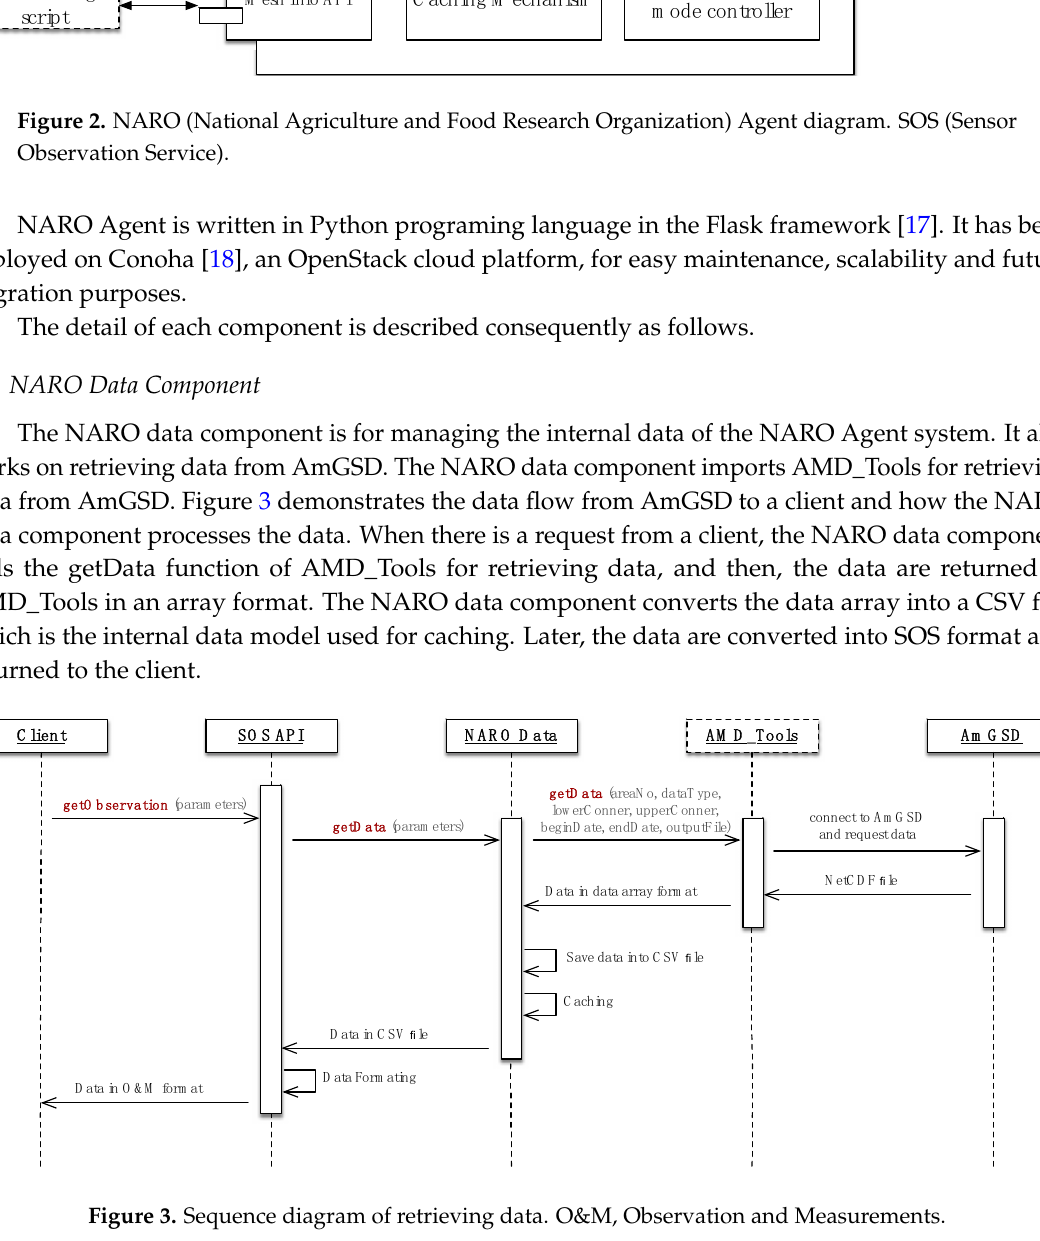
Figure 3. Sequence diagram of retrieving data. O&M, Observation and Measurements.